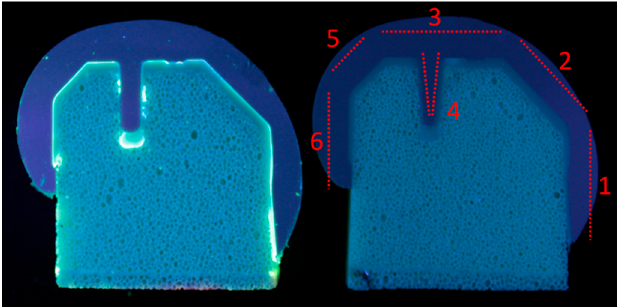
Figure 3. Proof-of-concept lateral condyle PEEK specimens cemented on bone-analog foam after 100,000 cycles in fluorescent dye: (Left) the implant under UV lighting showing complete interface dye fluorescence (score 3); and (Right) the same sample without UV lighting and how the interface was divided into 6 regions for analysis ( 1 , anterior flange; 2 , anterior chamfer; 3 , distal area; 4 , peg; 5 , posterior chamfer; 6 , posterior flange).